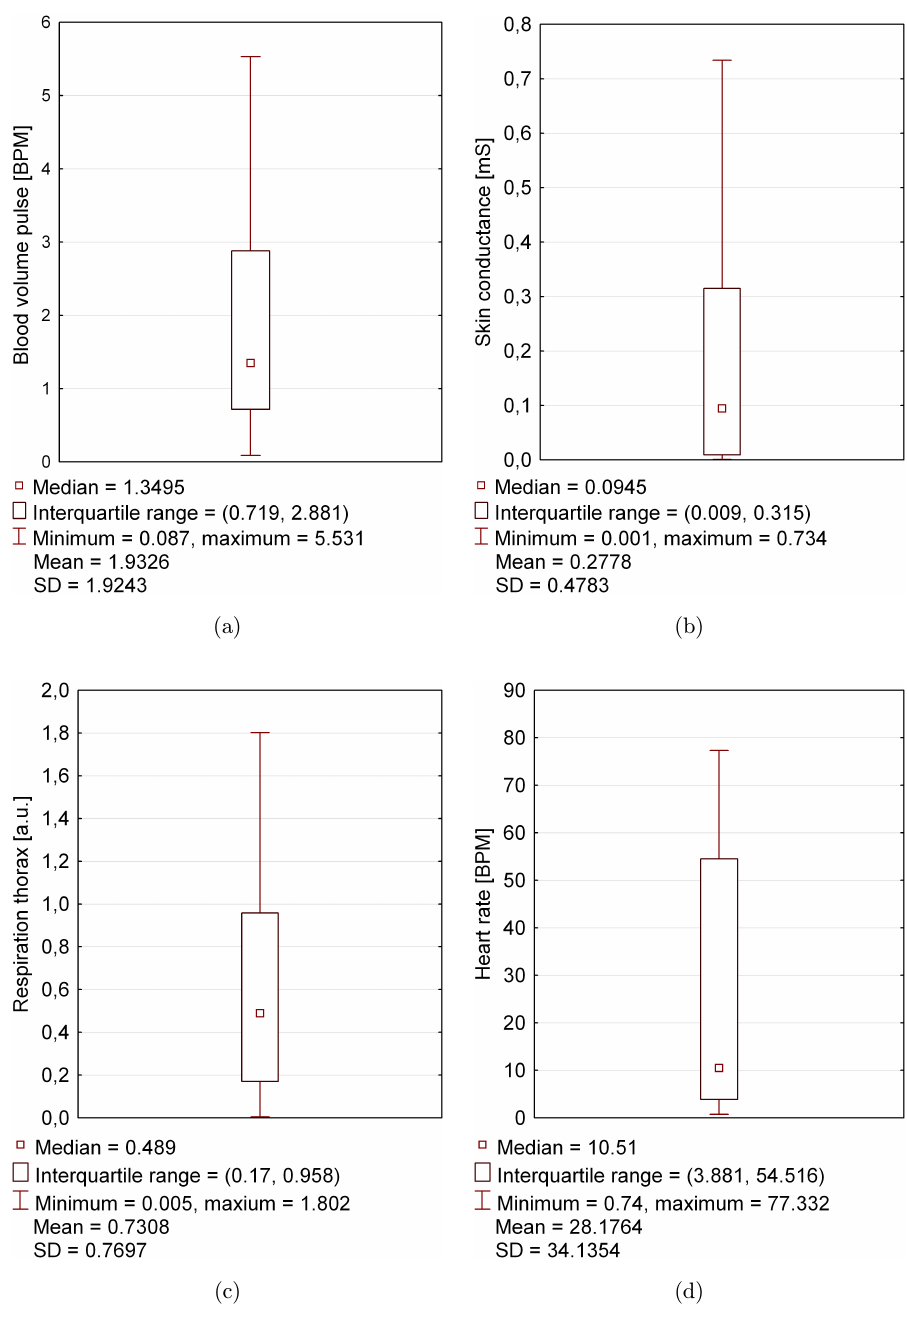
Fig. 3. Basic statistics for measured physiological parameters that show the biggest changes due to stressful condition: (a) BVP, (b) SC, (c) respiration thorax and (d) heart rate.